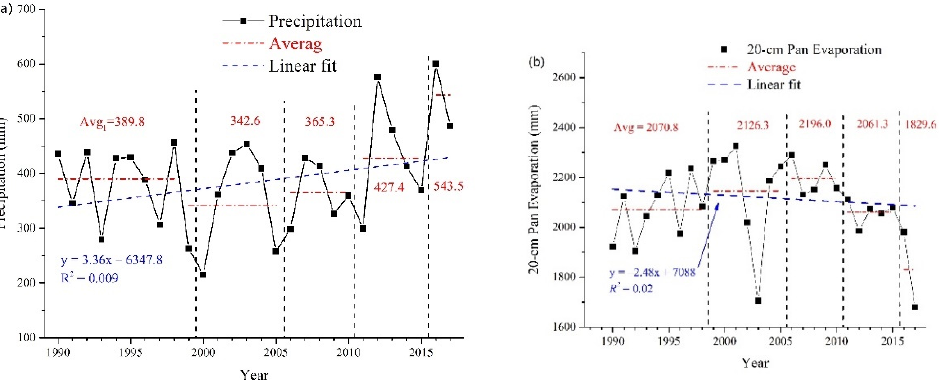
Figure 10. The variations of ( a ) annual precipitation and ( b ) 20 cm pan evaporation within the HN basin from 1990 to 2017.